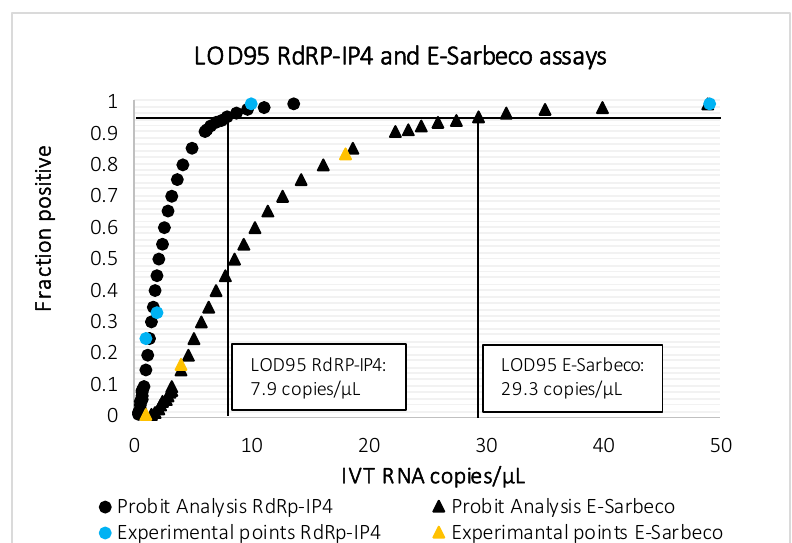
Figure 1. Probit analysis for LOD95 of RdRp-IP4 and E-Sarbeco assays.